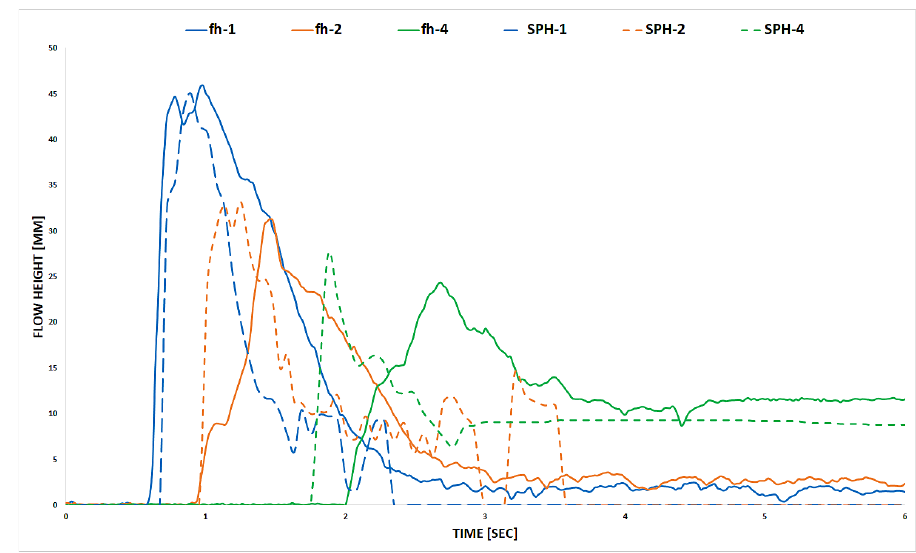
Figure 8. Experimental results vs. numerical results of the flow heights.